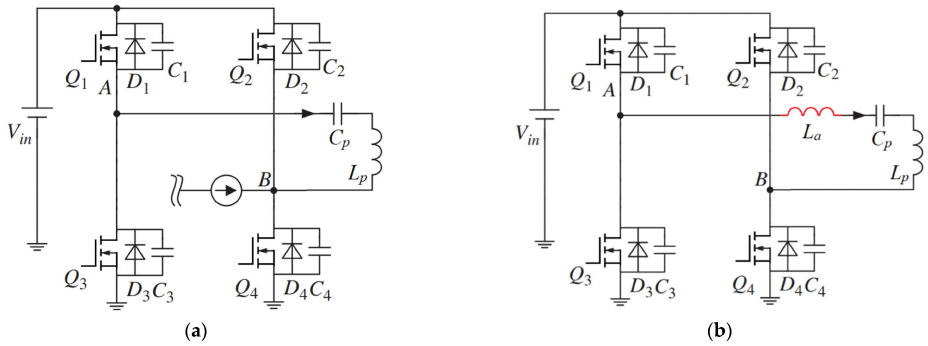
Figure 7. Proposed soft-switching circuit. ( a ) is the topology after adding the current source; ( b ) is the topology after replacing the current source with an inductance.